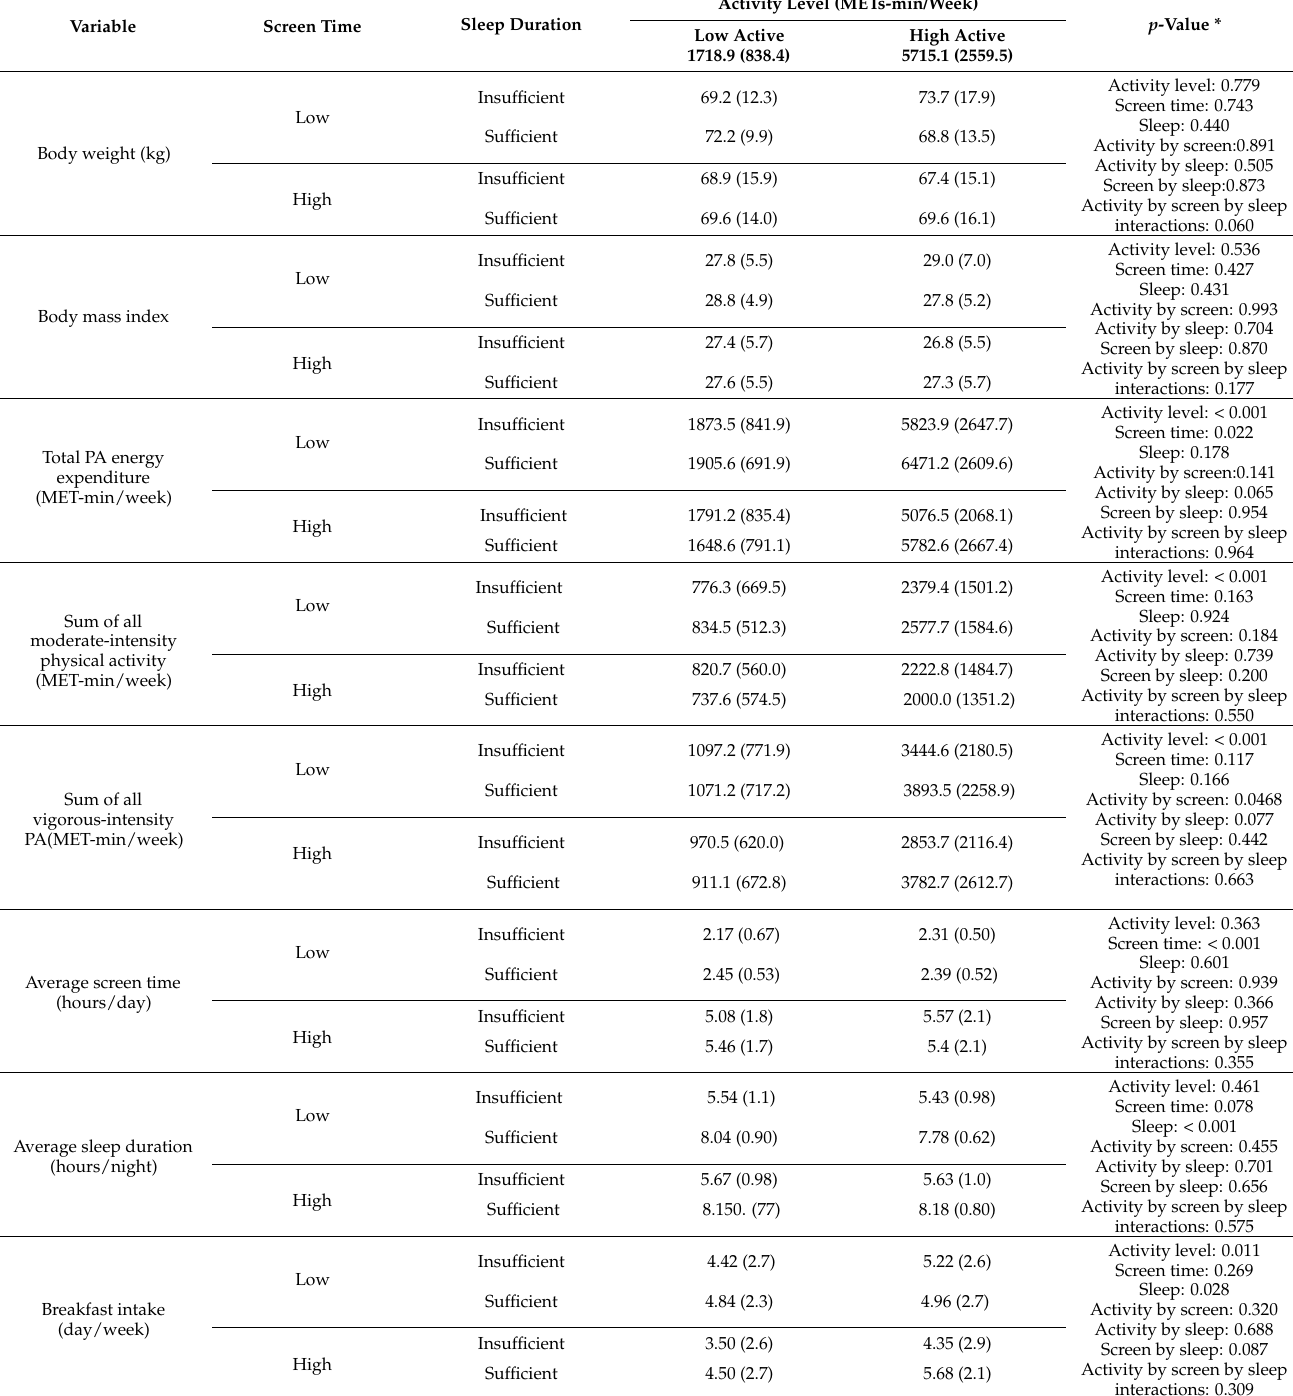
Table 6. Multivariable analysis (three-way MANCOVA) of selected anthropometric and lifestyle variables while controlling for age and socio-demographic factors stratified by total activity energy expenditure levels in METs-min/week for the participants (below or above 50%ile), screen viewing time in hours per day as low (less than 3 h per day) and high (3 or more hours per day), and sleep duration in hours per night as insufficient (less than 7 h per night) and sufficient sleep (7 or more hours per